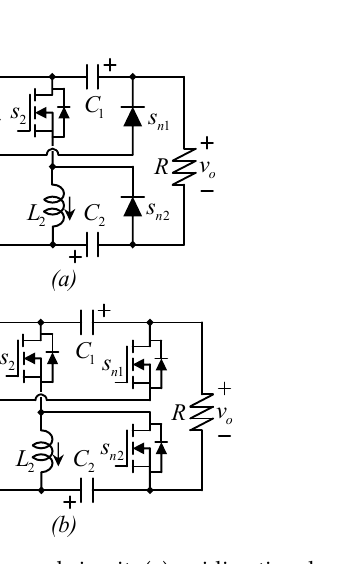
Figure 3. Equivalent circuits, according to the switching state, ( a ) when transistors are closed and ( b ) when transistors are open.